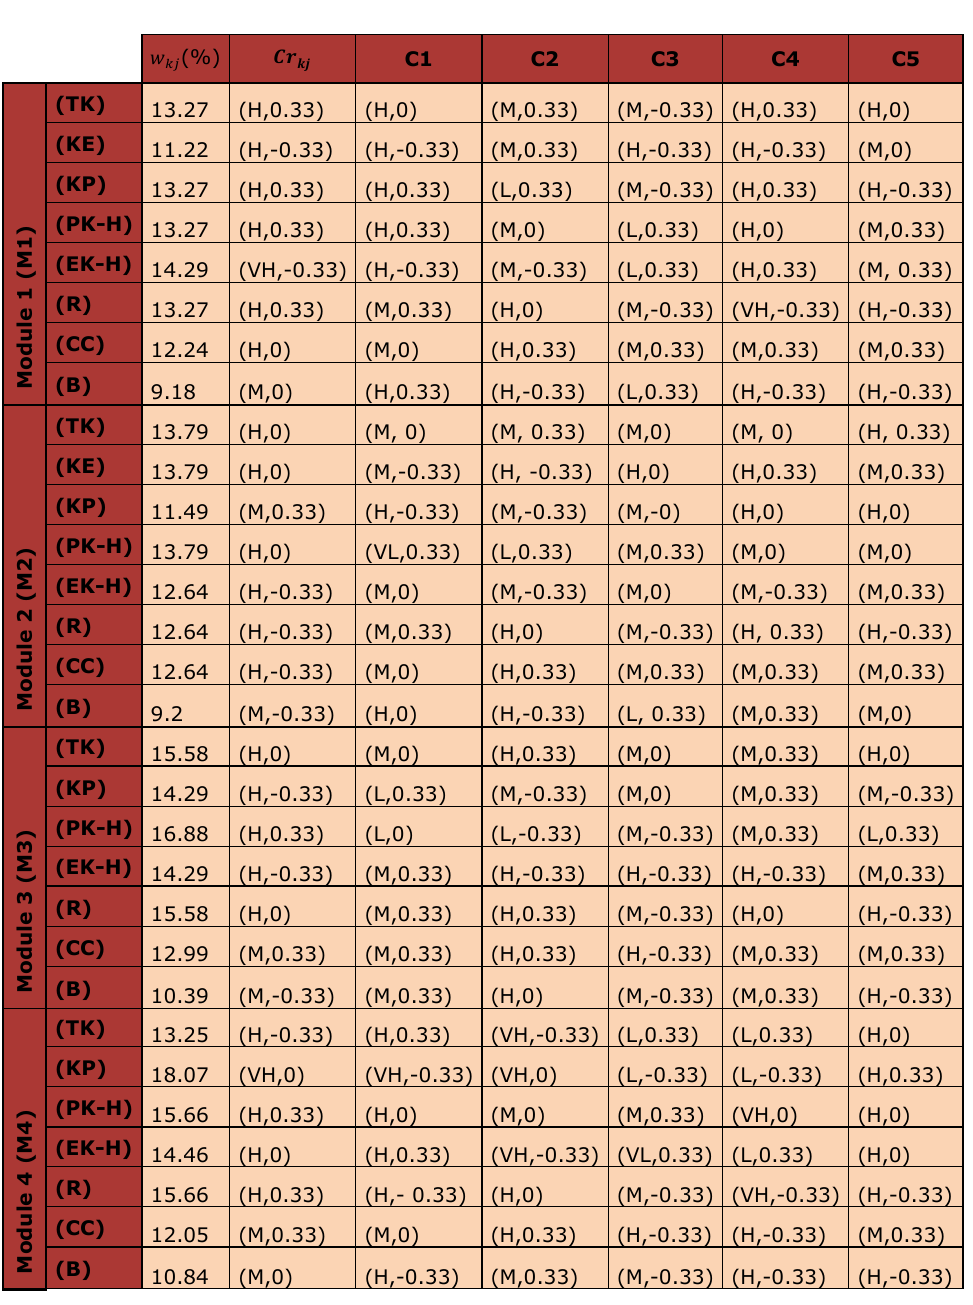
Table 3. The aggregated acquired and required competence resources levels and their corresponding degree of